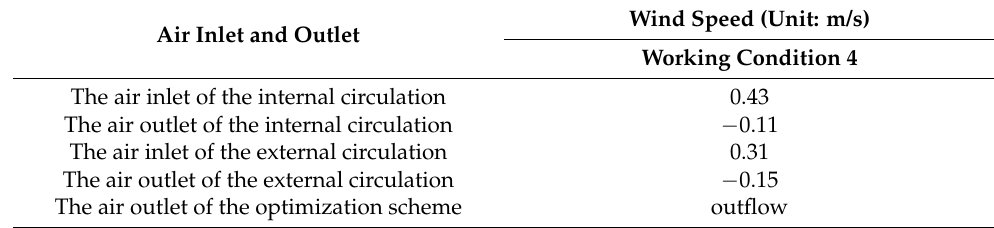
Table 7. Wind speed measurement at inlet and outlet of broiler chamber under improved working condition.